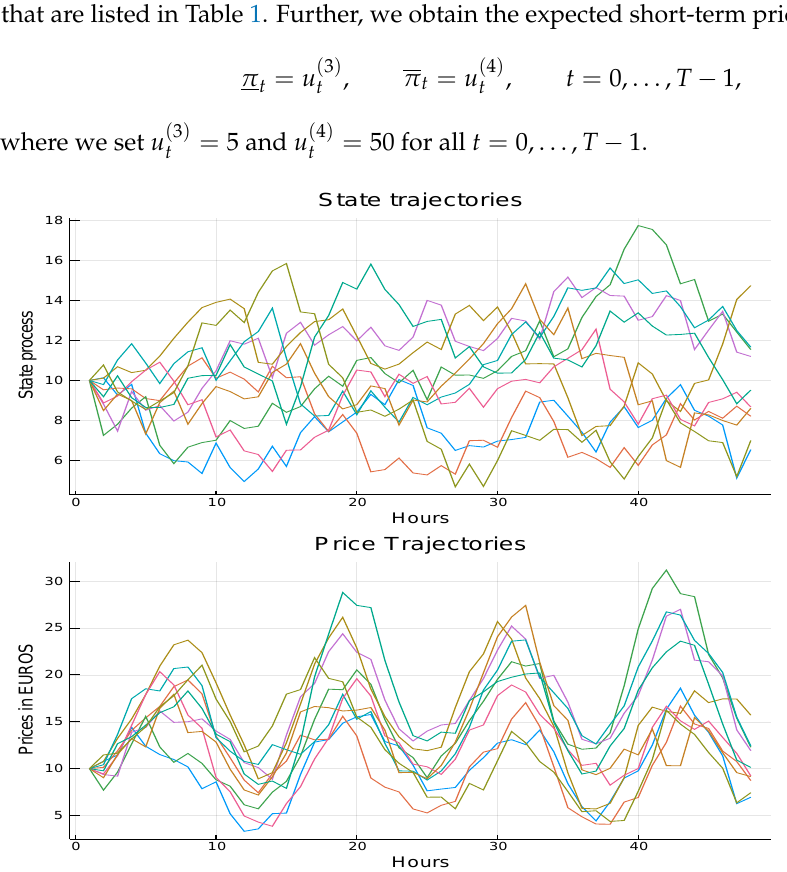
( 2 ) ) T and the t t = 0